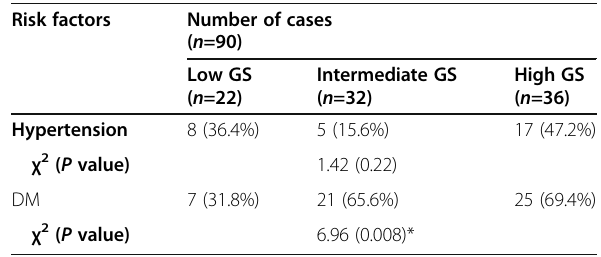
Table 4 Gensini score among the studied patients Gensini